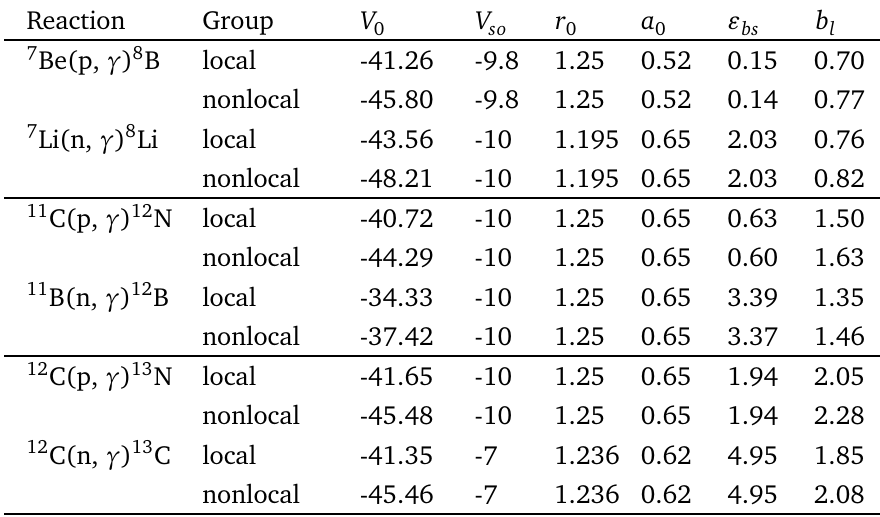
Table 1: Central potential depth ( V , MeV), binding energy ( (cid:34) 0 particle ANC ( b , fm − 1 / 2 ) for radiative proton / neutron capture reactions (the unit of l = r = r = a V is MeV, those of r and a are fm). Local potential parameters so c so so 0 0 are taken from ref. [ 3 ]